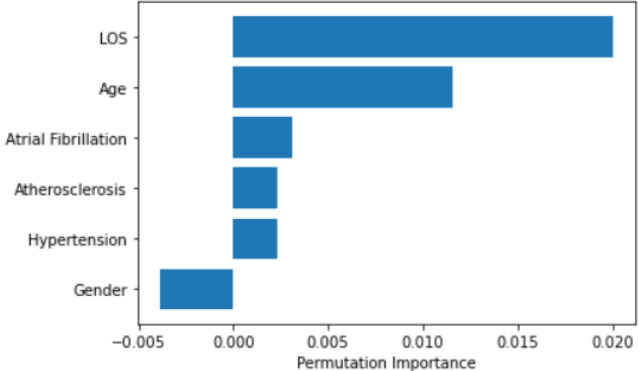
Figure 13. SVM permutation importance.